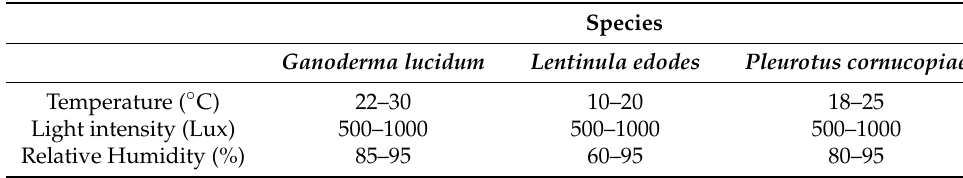
Table 2. Cultivation parameters used in the